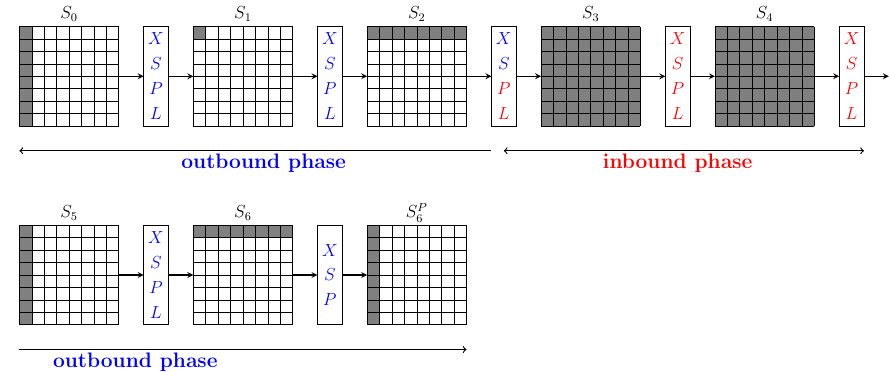
Figure 9: Collision attack on 6.5-round Streebog-256 compression